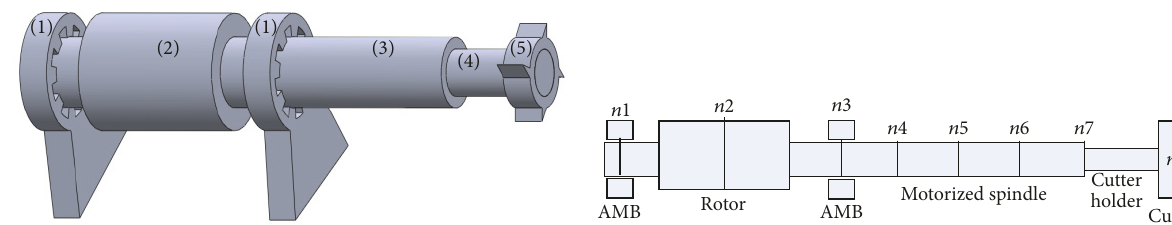
Figure 2: The flexible motorized spindle with the active magnetic